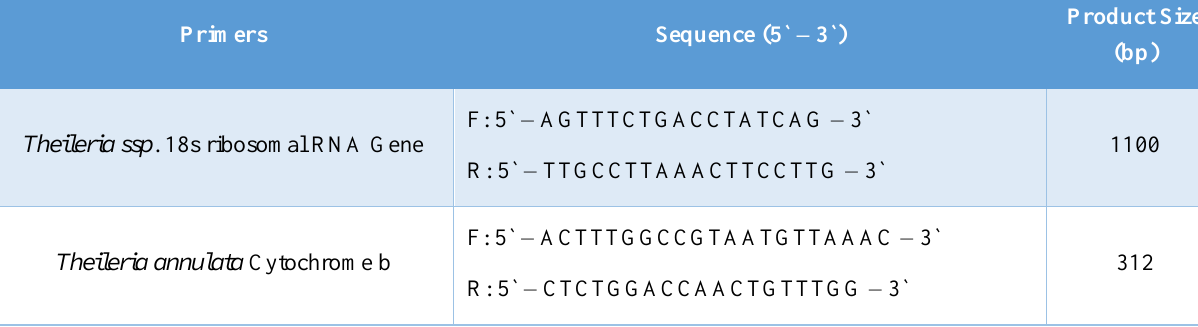
Table, 2: PCR Thermocycler system (Amplification program). Gene